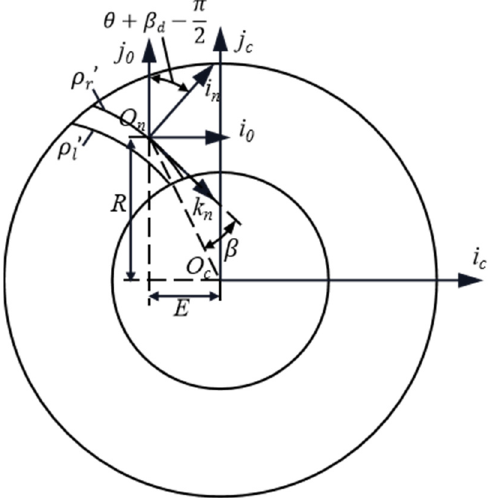
where β (cid:48) = β d , E = x (cid:48) , R = y (cid:48) , the tooth profile equation of the crown gear is: As shown in Figure 6, the coordinate system , , ( is established on the actual tooth alignment curve. The double-arc tooth profile scanned along the actual tooth align- ment curve to form the tooth profile of the crown gear. The E and R change, and their change law is related to the tooth alignment curve equation. The β d is the included angle between the tangent passing through any point and the connecting line between the point and the origin, and the central tooth alignment curve meets when β β= d where r i is the radius of each arc of the double-arc tooth profile, α i corresponds to the angle β tant curves of the left and right boundary tooth profiles meet at of each arc, and α i ∈ ( α i (cid:48) , α i (cid:48)(cid:48) ) , ( E i , F i ) is the center coordinate of the arc, i = 1, 2, ..., 8.